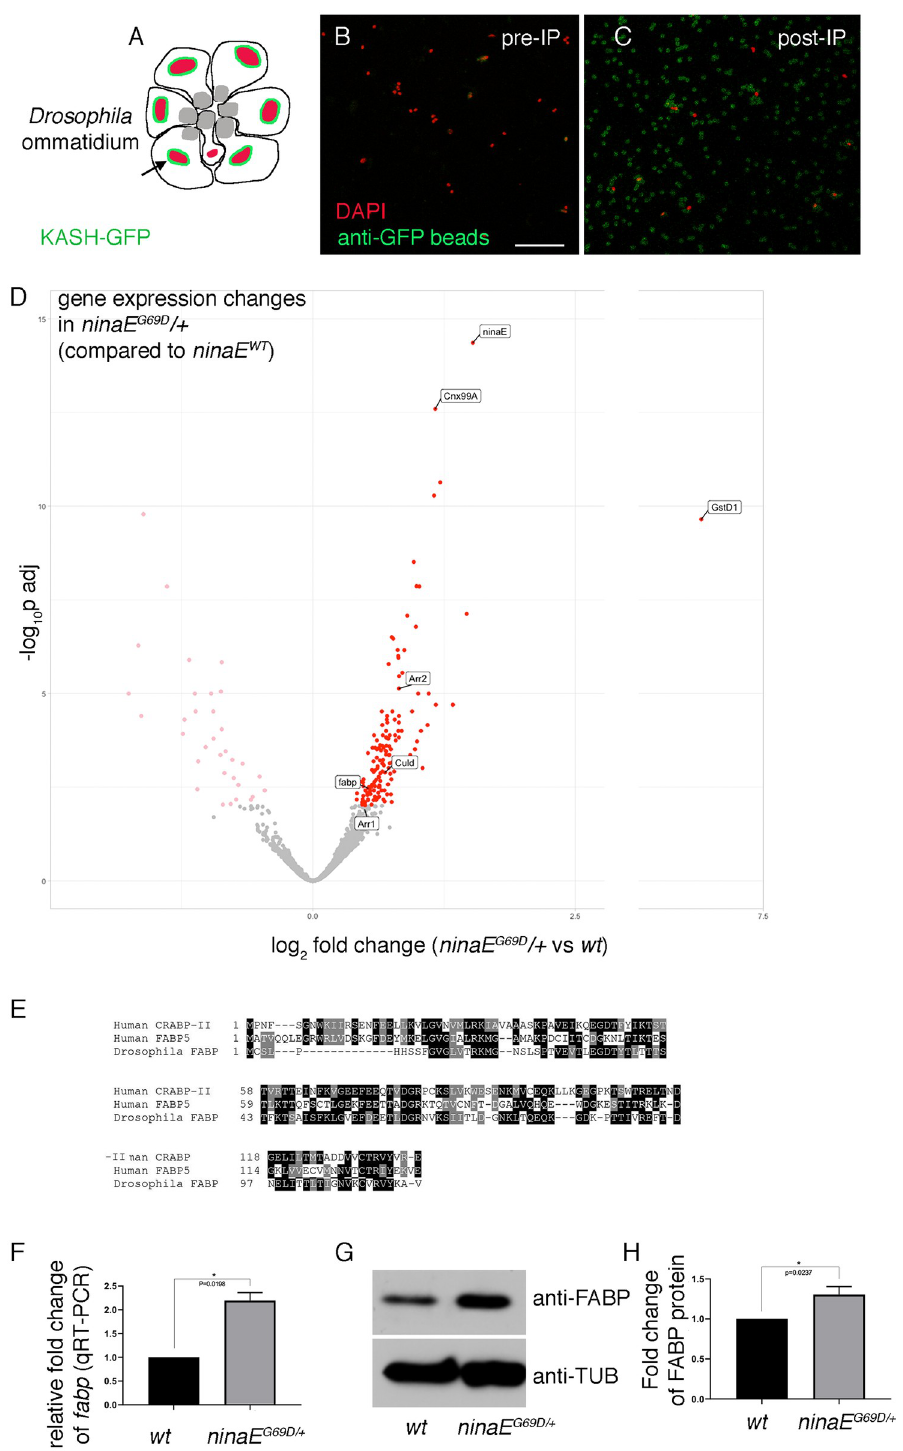
Fig 1. Photoreceptor-specific gene expression profiling in ninaE G69D eyes. (A) A schematic diagram of the Drosophila ommatidium. Shown are seven photoreceptor cells, R1 to R7. KASH-GFP (green) coats the outer membranes of R1 to R6 nuclei (red). Rh1 localizes to the apical membrane structure known as rhabdomeres (gray). (B, C) Purification of photoreceptor nuclei tagged with EGFP-Msp300 KASH (KASH-GFP). Rh1-Gal4 was used to express uas-KASH-GFP in R1 to R6 photoreceptors. Nuclei are labeled with DAPI (red) and the anti-GFP beads are in green.